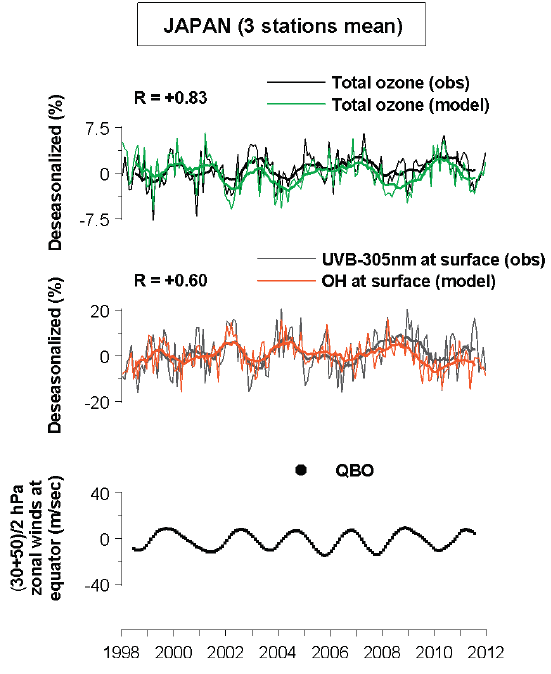
Figure 5. Column ozone variation (modeled and observed), tropospheric OH variation (modeled with Oslo CTM2) and observed tropospheric UV-B radiation for three Japanese stations, and observed zonal winds at 30 and 50 hPa at the Equator (updated from